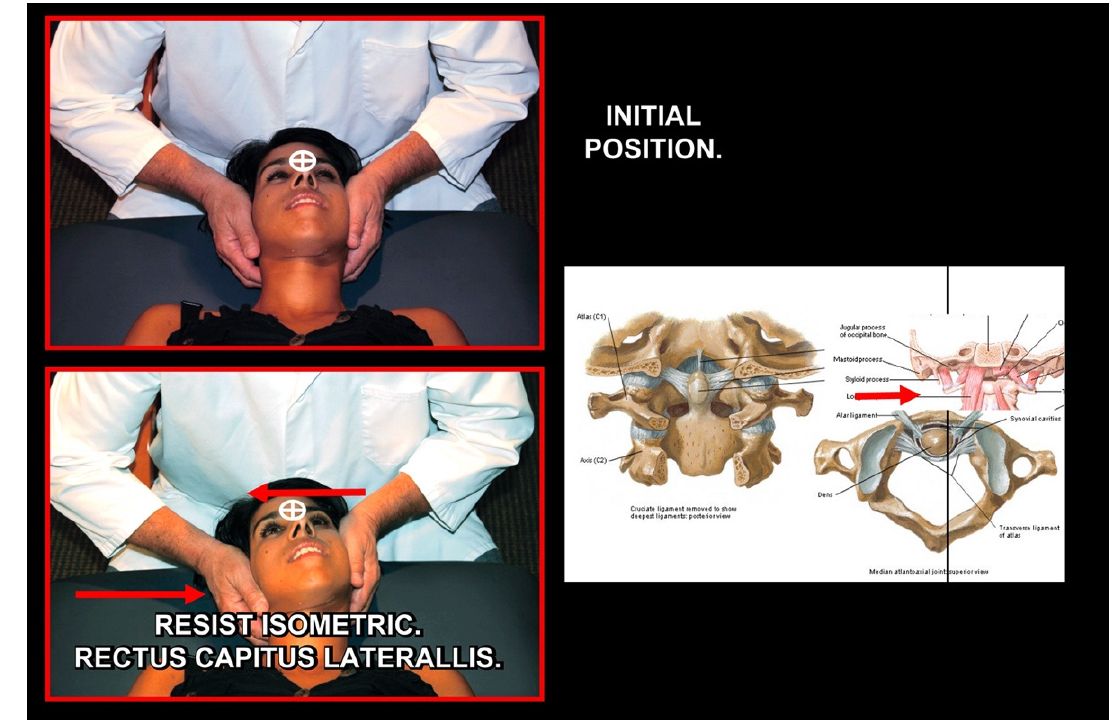
Figure 22. Normalization of C 2 left rotation. Source: Rocabado Institute, Chile. Employing alar ligament and rectus capitis lateralis using neuromuscular techniques.